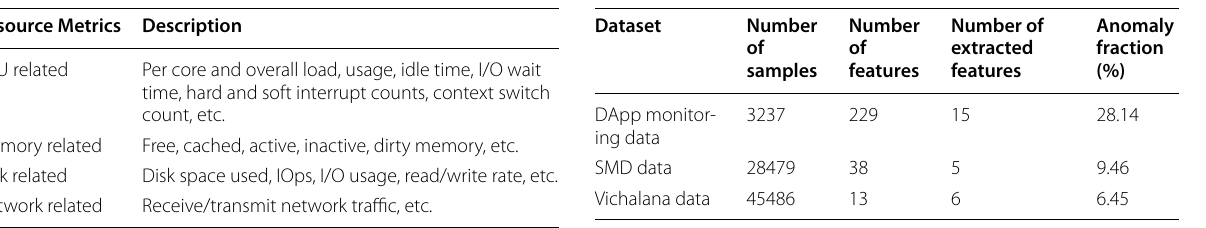
Table 3 General information of three